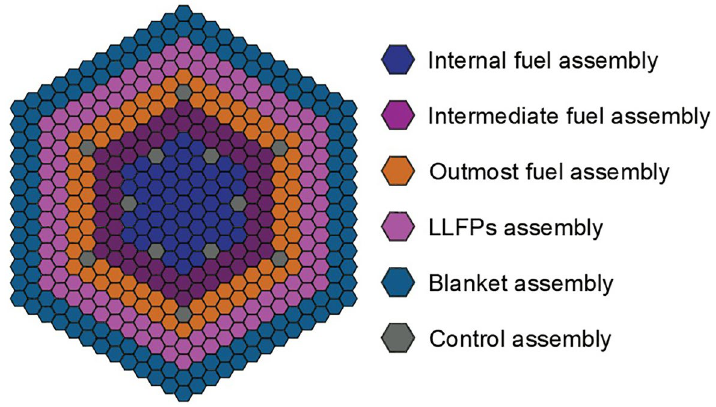
Figure 1. Schematic diagram of the LFR core.